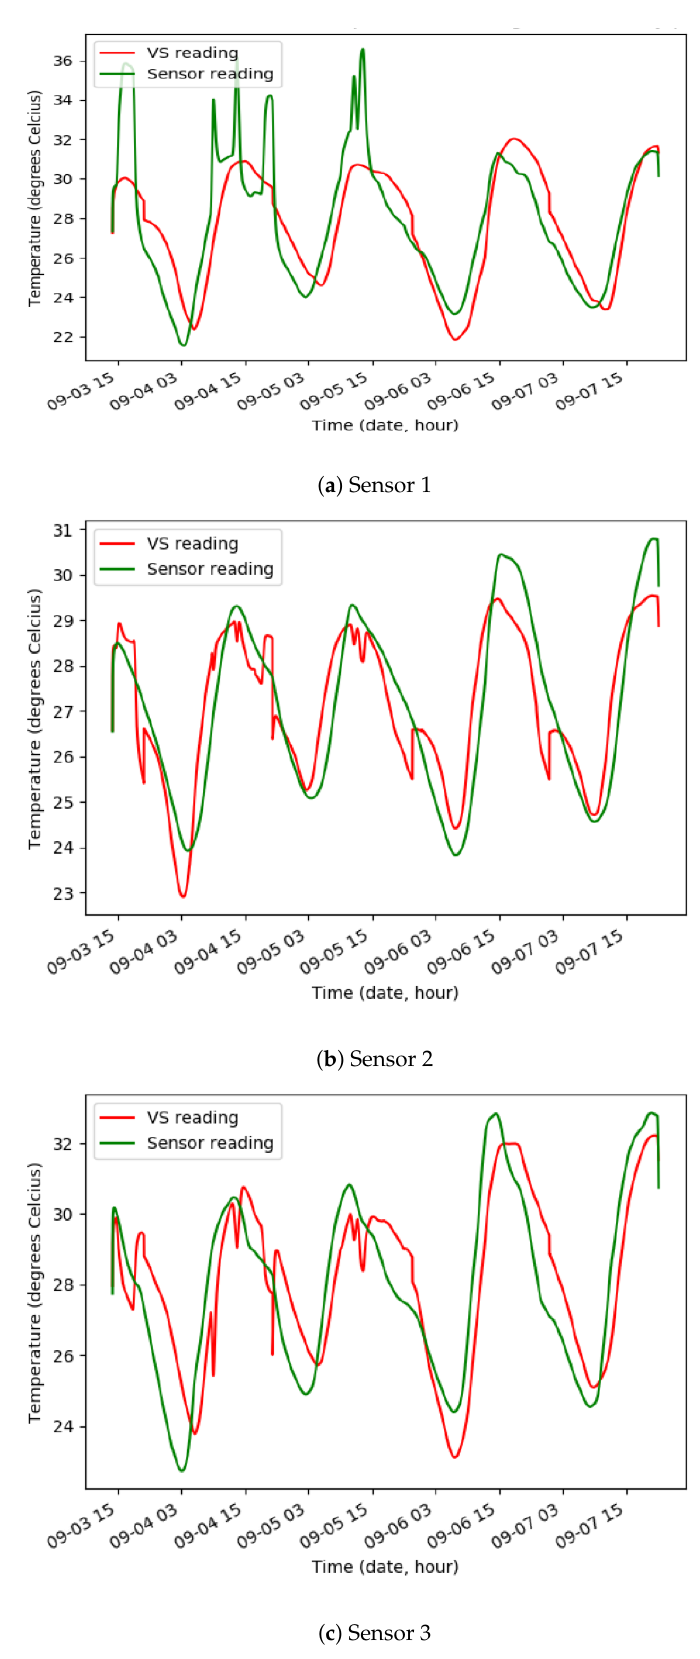
Figure 8. Virtual Sensor Readings in small residential building.